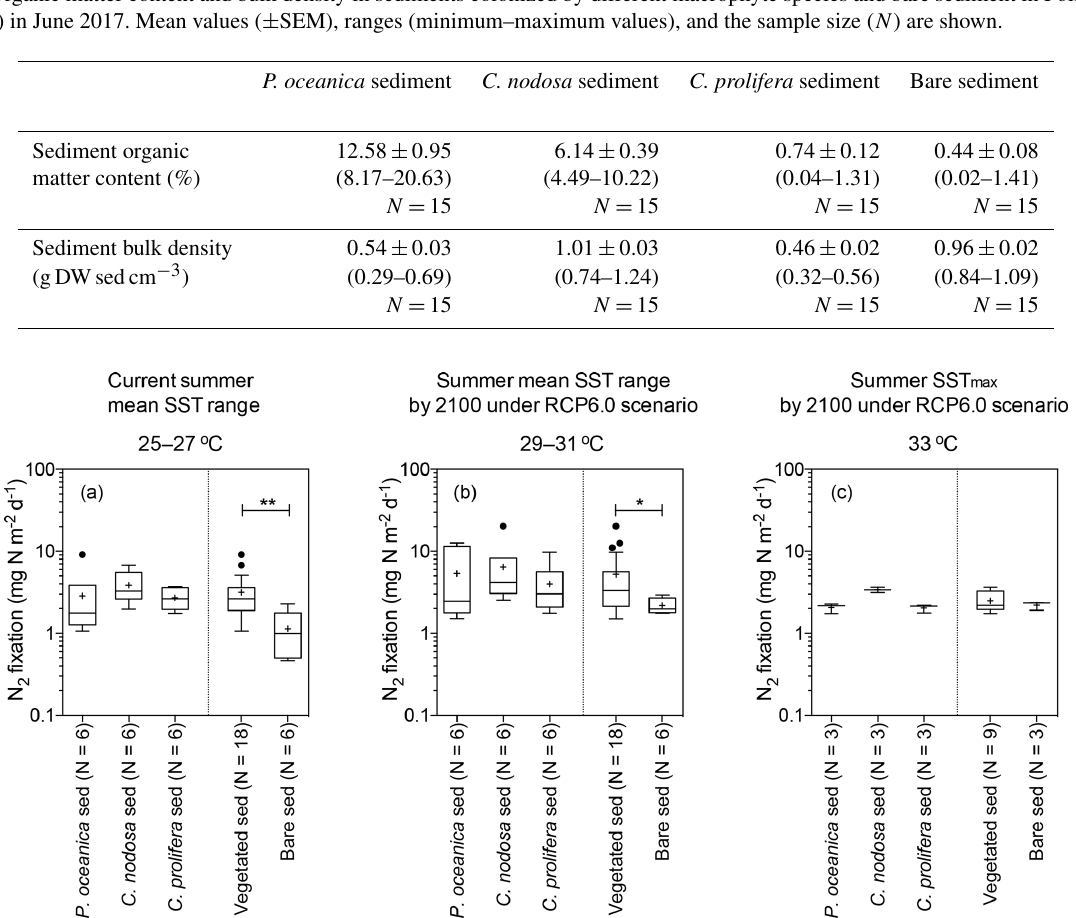
Figure 1. Box plot of the N 2 fixation rates (expressed by area) of sediments colonized by different macrophytes (as well as grouping all vegetated sediments together) and bare sediment measured at the current summer SST range (25–27 ◦ C, a ), the projected summer mean SST range by 2100 under RCP6.0 scenario (29–31 ◦ C, b ), and the projected summer SST max by 2100 under RCP6.0 (33 ◦ C, c ). Boxes extend from the 25th to 75th percentiles, whiskers are calculated using the interquartile distance (IQR) according to the Tukey method, lines inside boxes represent the median, “ + ” represents the mean, and dots represent individual values greater than the 75th percentile plus 1.5 X IQR. Statistically significant differences are indicated by asterisks; ∗ indicates p< 0 . 05 and ∗∗ indicates p< 0 . 01. The sample size ( N ) is also